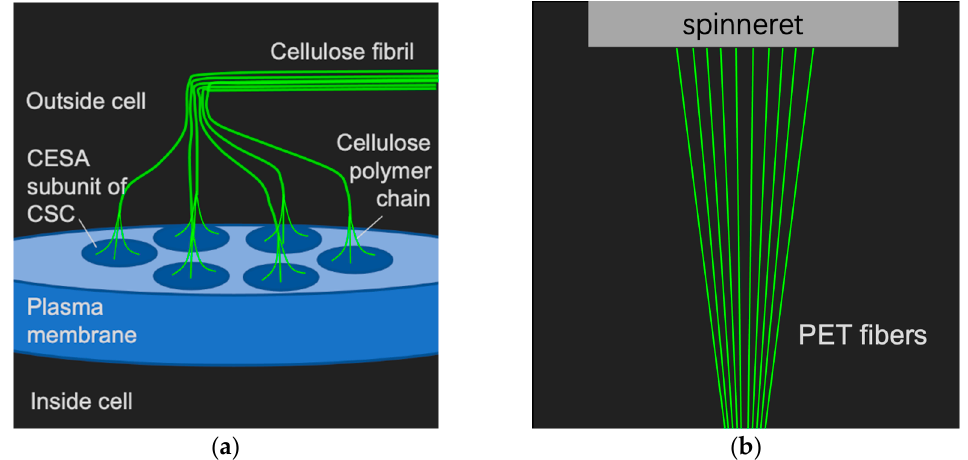
Figure 3. Schematic illustrations of fiber formation in natural and manufacturing processes. ( a ) Schematic representation of a rosette CSC producing cellulose polymer chains that self-assemble to form an 18-chain fibril, inspired by refs. [28,29]; ( b ) Schematic diagram of a spinneret for producing continuous PET filament fibers by melt spinning, where each fiber strand contains many PET polymer molecules.